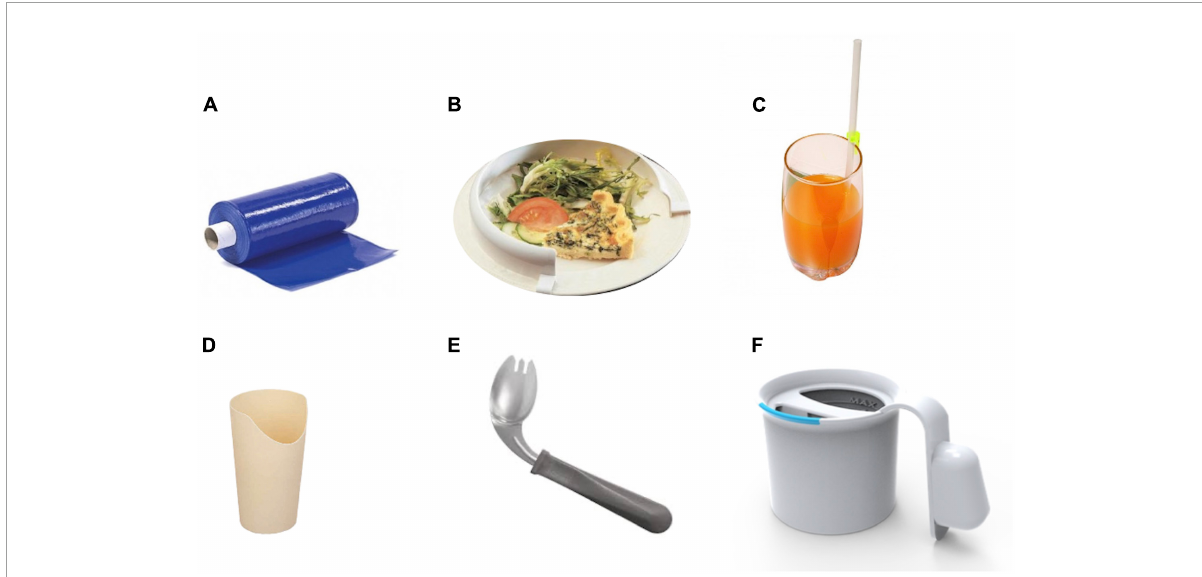
FIGURE6 Modified eating and drinking equipments for patients with PD. (A) The plate mat – a non-slip material patients can put under a plate or bowl to keep it from moving on the table, (B) the plate guard – a 2.5 cm acrylic or metal border that fits onto a plate. Patients push the food up against the guard, and it falls onto the eating utensil, (C) the one-way valve straw, (D) the nosey cup, (E) the spoon–fork (Permission obtained from https://www.parkinson.org), and (F) the anti-choking mug with a unique design of an inner slope to allow an individual user to drink from this mug without bending the neck or tilting the head. A valve inside the mug allows a maximal amount of 10 mL per sip of